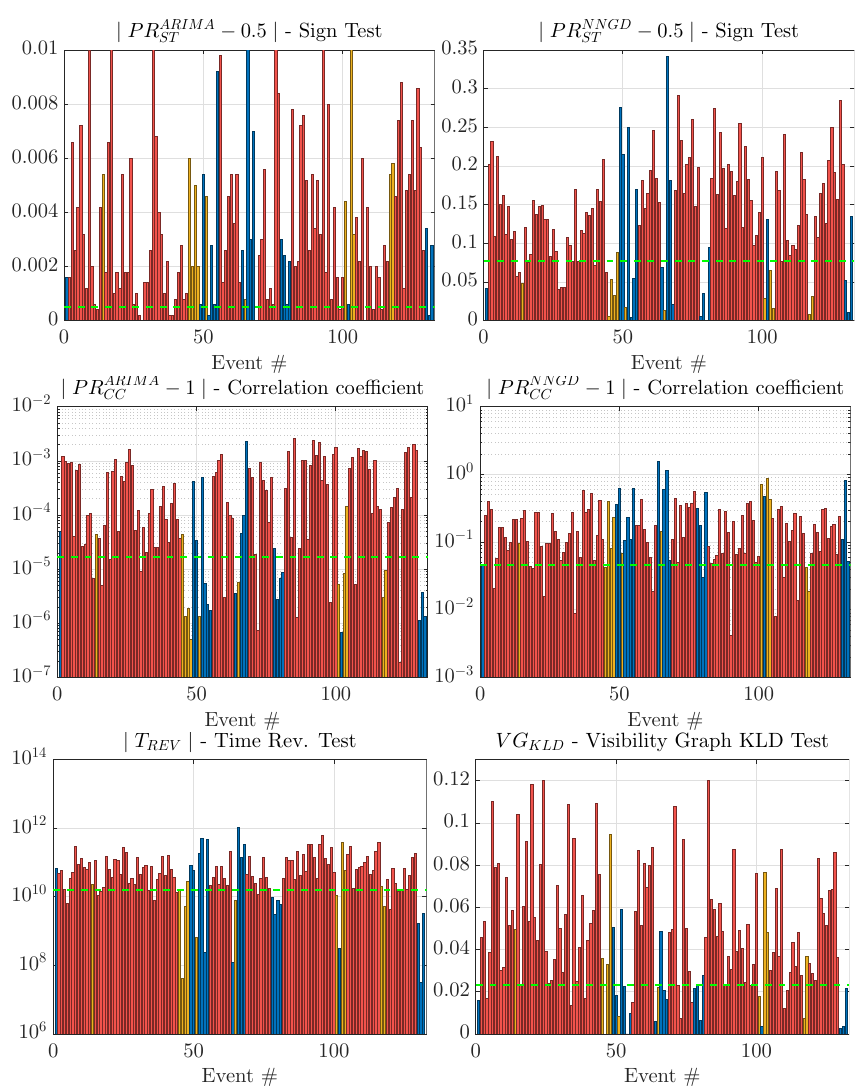
Figure 9. Assessment of the arrow-of-time metrics in the database of real events (Y axis in arbitrary units). The colors indicate the human expert classification: red corresponds to UNDEX, blue cor- responds to non-UNDEX, and yellow corresponds to UNSURE categories. The threshold (dashed green line) was set to obtain a fixed detection of UNDEX events equal to